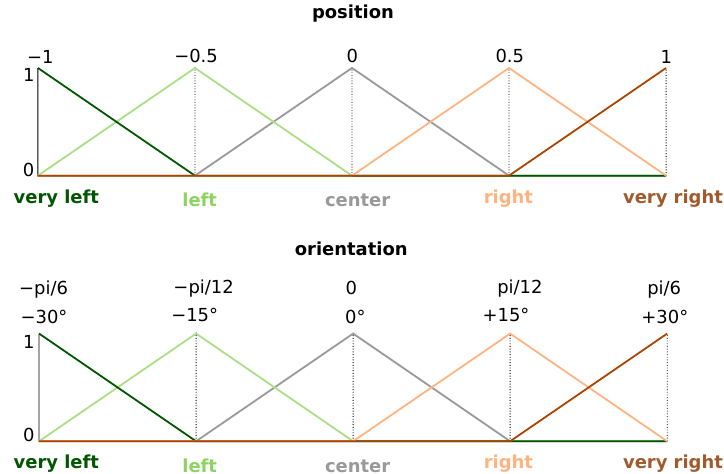
Figure 9. Input membership functions.